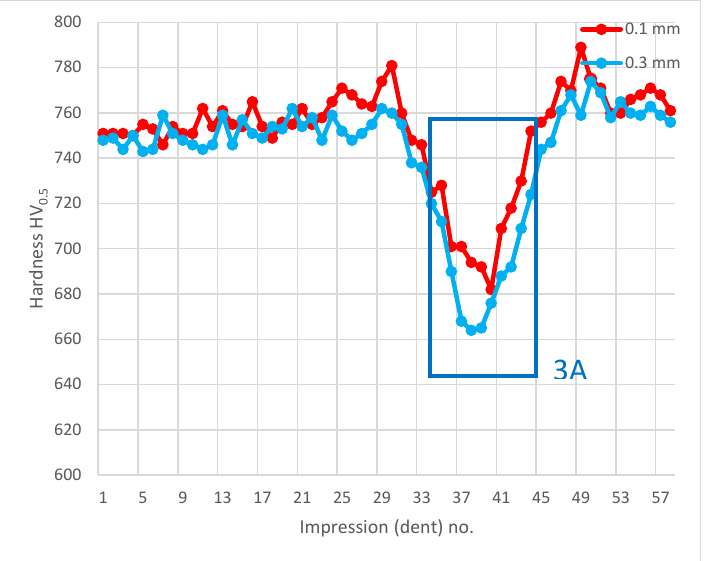
Figure 9. Pattern of hardness verification. Paths depth (distance from tooth surface): 0.1 mm and 0.3 mm. Cross-section F-F, zone: 3A.